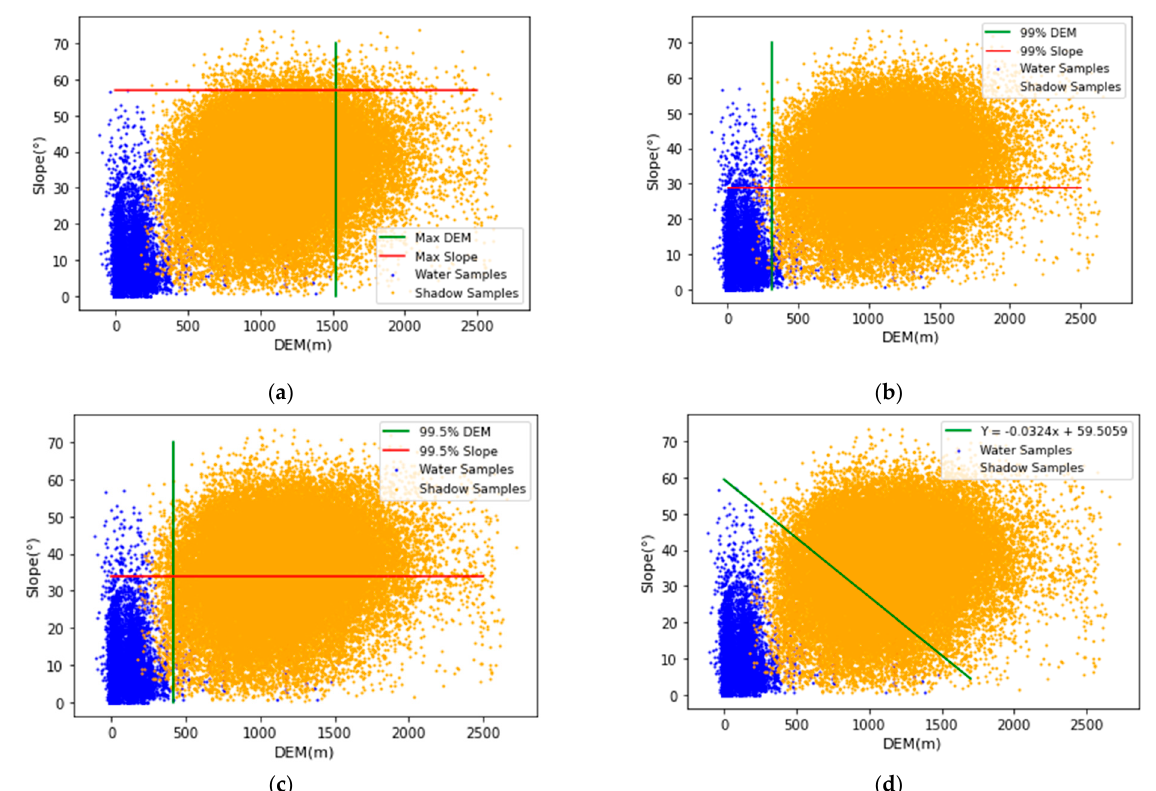
Figure 7. The schematic figures of mountain shadow removal methods. ( a ) Method 1, ( b ) Method 2, ( c ) Method 3, ( d ) Method